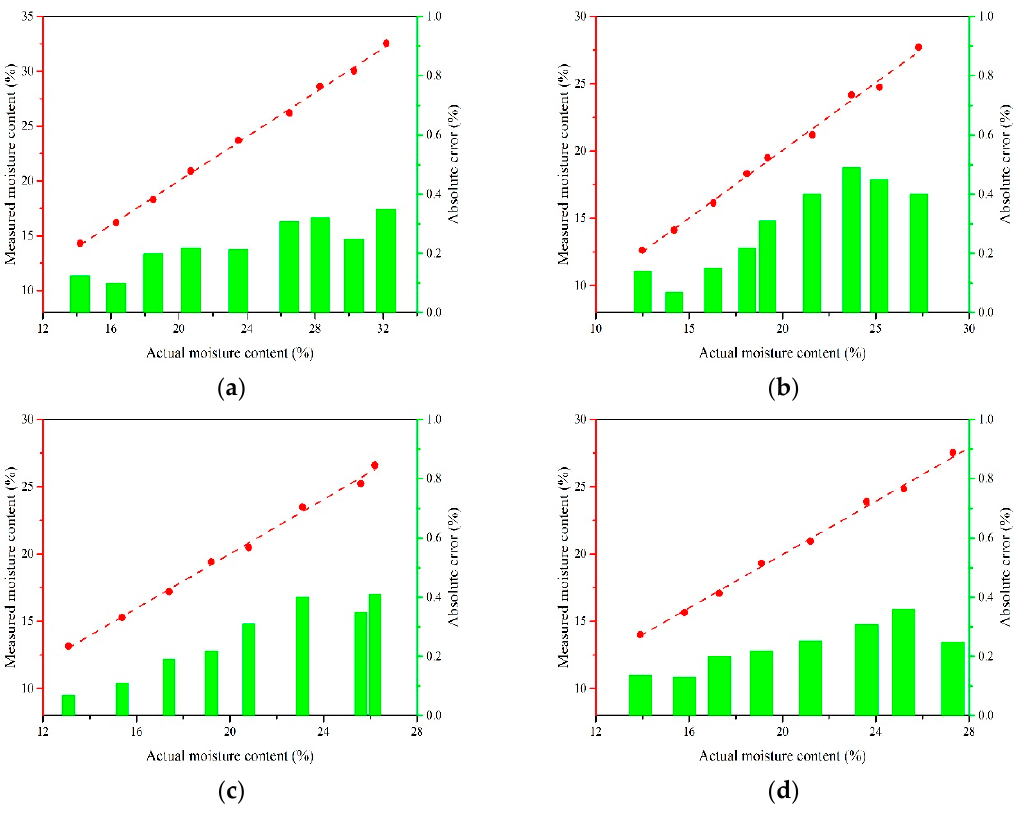
Figure 14. Comparison between measured values and actual values of moisture content in lab tests.